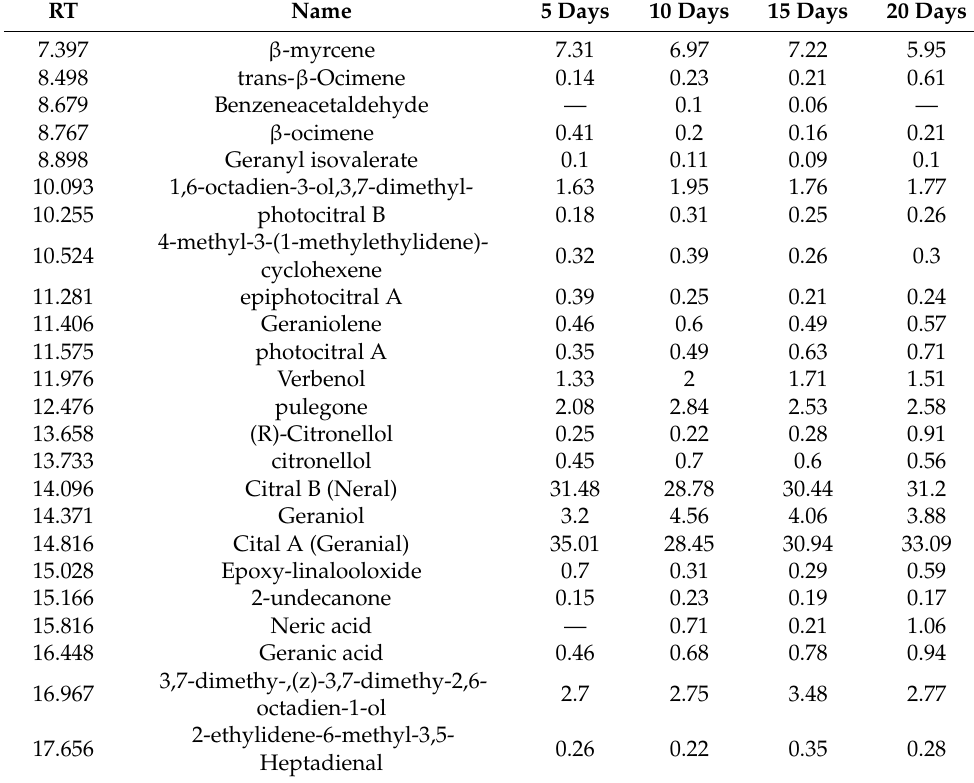
Data represent means ± standard deviation. Different letters above represent significant differences. Table 4. Chemical compositions (%) of the lemongrass, Cympobogon citratus , essential oil as affected by irrigation